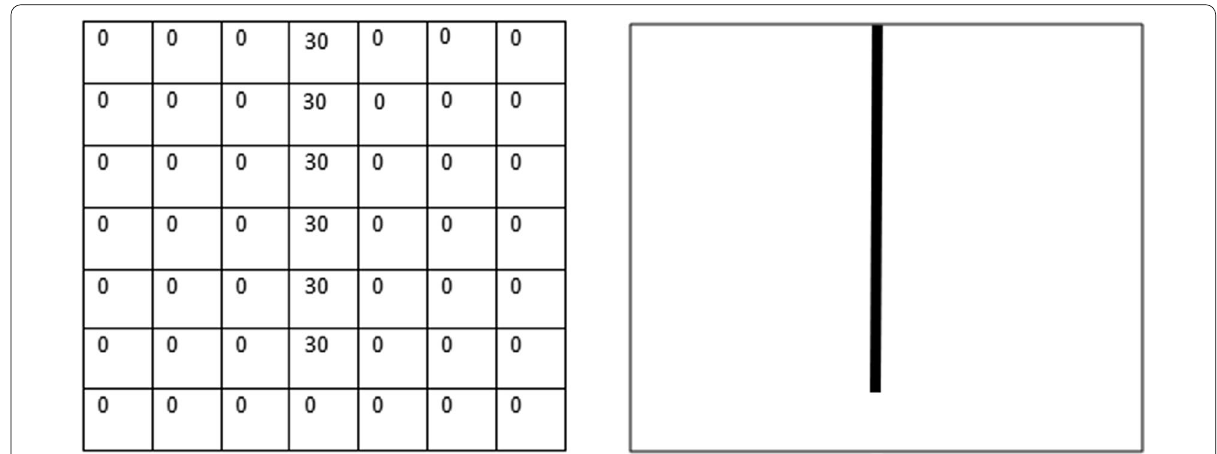
Fig. 13 Pixel representation of a vertical line filter (left) and its visualization (right)